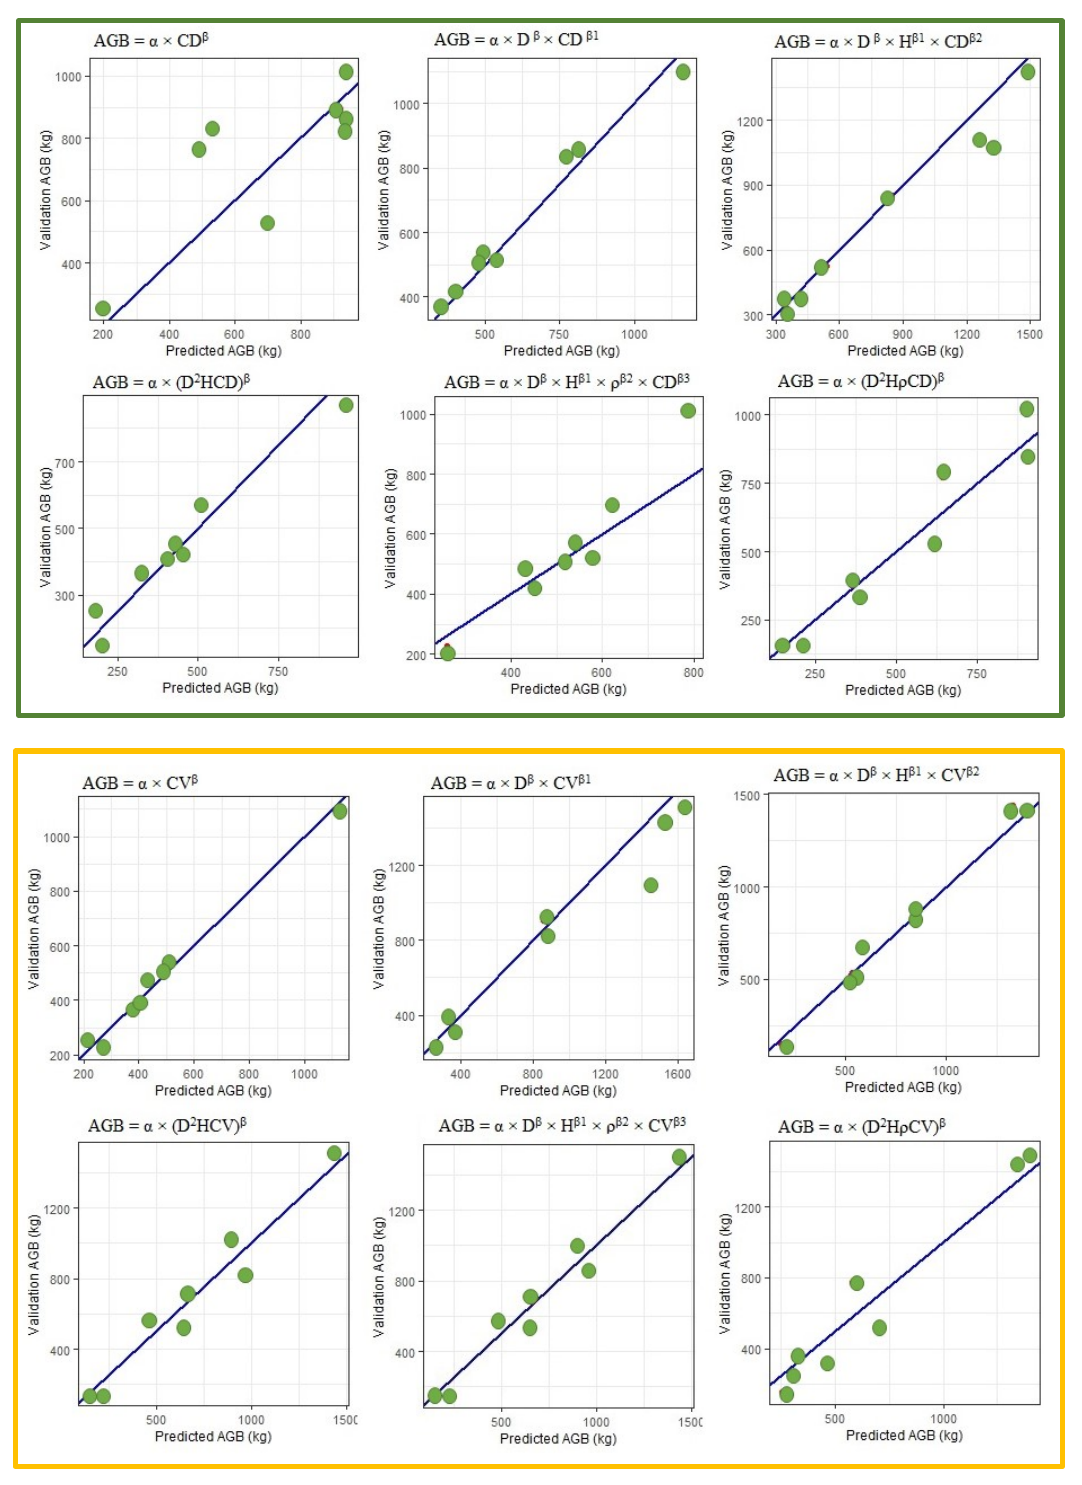
Figure 4. Observed and predicted plots for AGB models validated for all biomass models using MCCV method. Plots with blue border were validated for Equations (3)–(9) with compound predictor variables of D-H- ρ , cross validation procedure was used 80% data used for training, 20% data for testing, the process is repeated 100 times; Plots with green border validated and repeated 40 times for Equations (12)–(17) with compound predictor variables D-H- ρ -CD. The same process was applied for Equations (18)–(23) with compound predictor variables D-H- ρ -CV and plots with orange border. See Table S2 for criteria associated with these